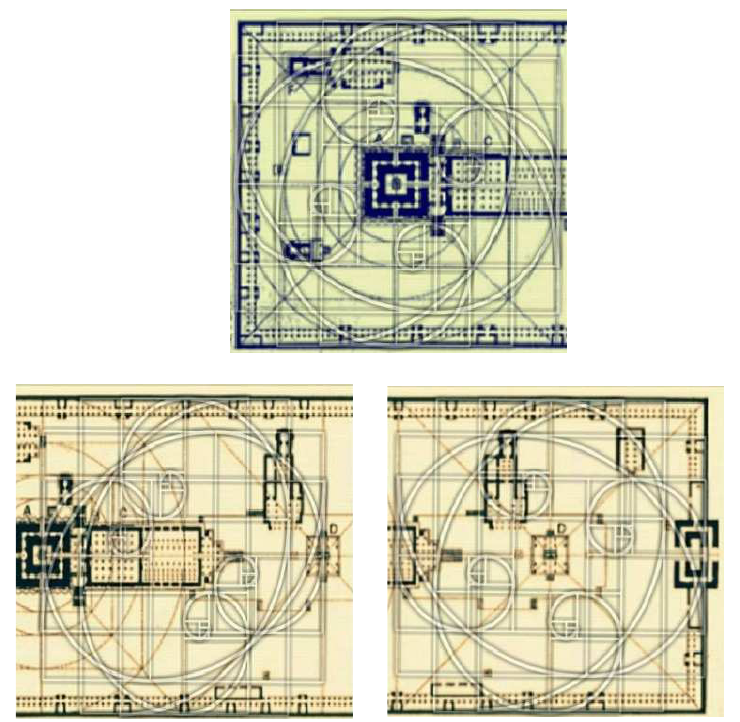
Figure 9. Golden ratio of the Brihadeeshwarar temple using Phi Spiral